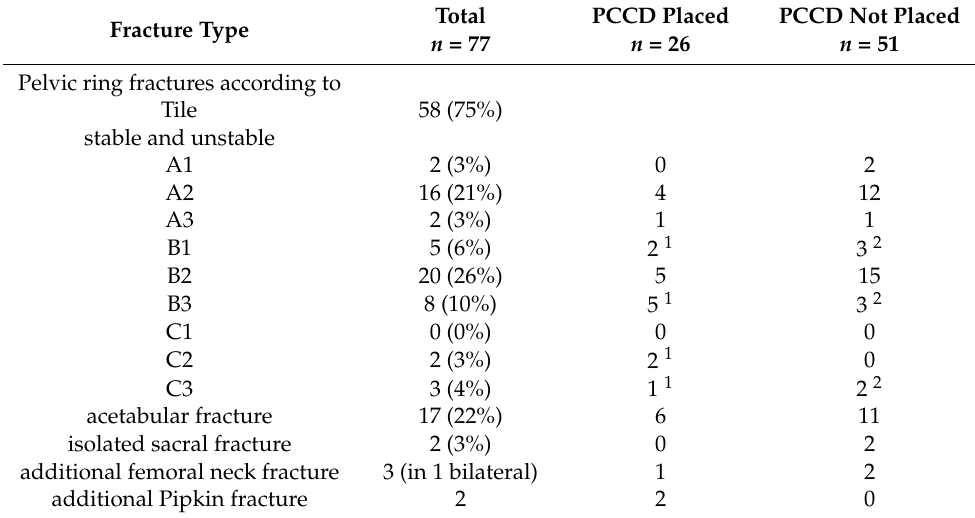
Table 2. Prevalence of fractures and pelvic circumferential compression device